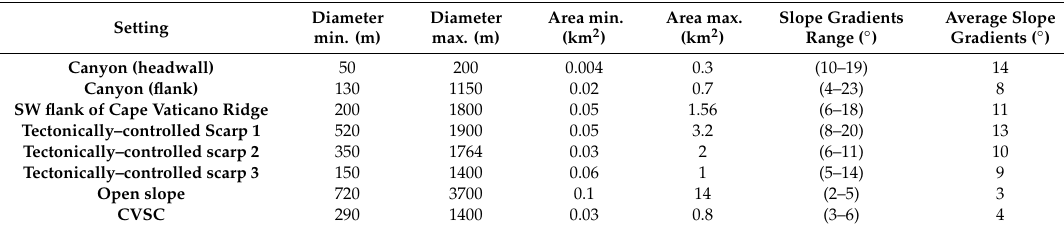
Table 1. Maximum (max) and minimum (min) values of areas and diameters associated with the landslide scars recognized in each physiographic / morphological domain present in the study area using multibeam bathymetry. CVSC: Capo Vaticano Scar